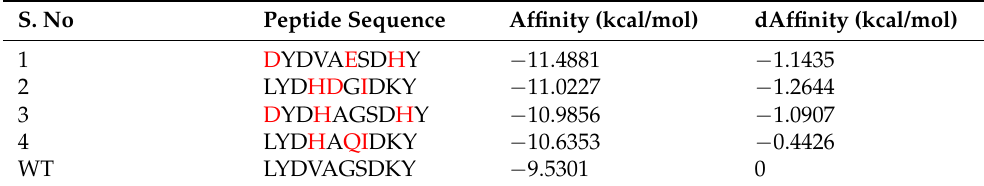
Table 1. Peptide design by substituting residues in